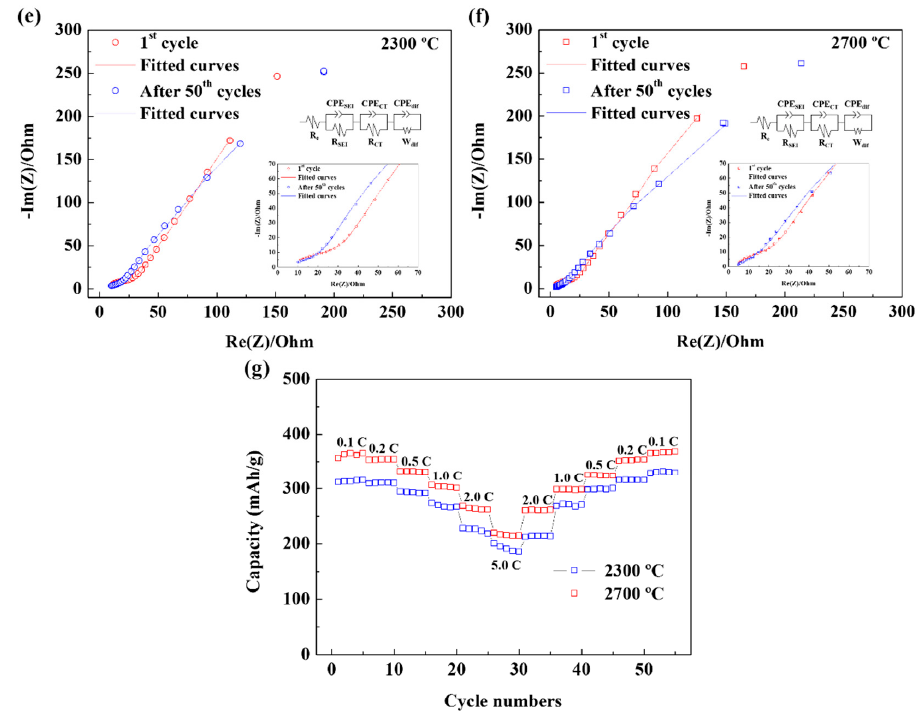
Figure 5. ( a ) Cycling performance of the annealed soot and SuperP at a rate of 1 C. ( b ) Discharge/charge profiles for the first cycle at a rate of 0.2 C. The numbers indicate the initial Coulombic efficiencies. ( c ) CV curves of the annealed soot for the first cycle at a scanning rate of 0.2 mV/s in voltage range of 0.005–3 V (vs. Li/Li + ). ( d ) CV curves of soot annealed at 2700 °C at a scanning rate of 0.2 mV/s in voltage range of 0.005–3 V (vs. Li/Li + ). ( e ), ( f ) Nyquist plots of the soot annealed at 2300 and 2700 °C after 1 and 50 cycles. ( g ) Rate capability for soot annealed at 2300 and 2700 °C. The soot annealed at 1400 °C showed the lowest reversible capacity, while that annealed at 2300 °C showed a capacity comparable to that of SuperP. Moreover, the first-cycle Coulombic efficiency shows that the soot treated at 2300 °C exceeds SuperP in efficiency (Figure 5b). Since heat-treated soot has a much smaller specific surface area than SuperP, a lower amount of the solid electrolyte interphase (SEI) layer is formed on its surface, and consequently, the Coulombic efficiency of the entire electrode material is increased. Therefore, in order for the soot to surpass commercial carbon black in performance as a conductive material, the crystallization should be carried out at a temperature above 2000 °C. Figure 5c compares the CV curves of the first cycle for the annealed soot samples, confirming the presence of residual impurities in a voltage range of 0.005 to 3 V. For the soot annealed at 1400 °C, redox peaks, which are presumed to be due to impurities in the carbon rather than electrolyte decomposition, appeared at 1.8 V. However, for soot annealed at 2700 °C, these impurity peaks disappeared. The first three cycles of the CV curves for the soot annealed at 2700 °C (Figure 5d) confirm the formation of a stable SEI layer. The first peak located at 1.1 V can be assigned to the irreversible reduction of the electrolyte additive FEC. The second broader cathode peak at 0.25– 1.1 V corresponds to the decomposition of EC/DEC and the formation of an SEI layer. Finally, a sharp peak indicating the insertion of Li ions is observed at 0.25 V or lower. After the first cycle, the cathode reduction peaks disappear, and CV curves in different cycles almost overlap without any apparent change in the peak current or peak potential. This indicates the excellent reversibility of the Li insertion and extraction reactions and the stability of the soot-based conductive material.